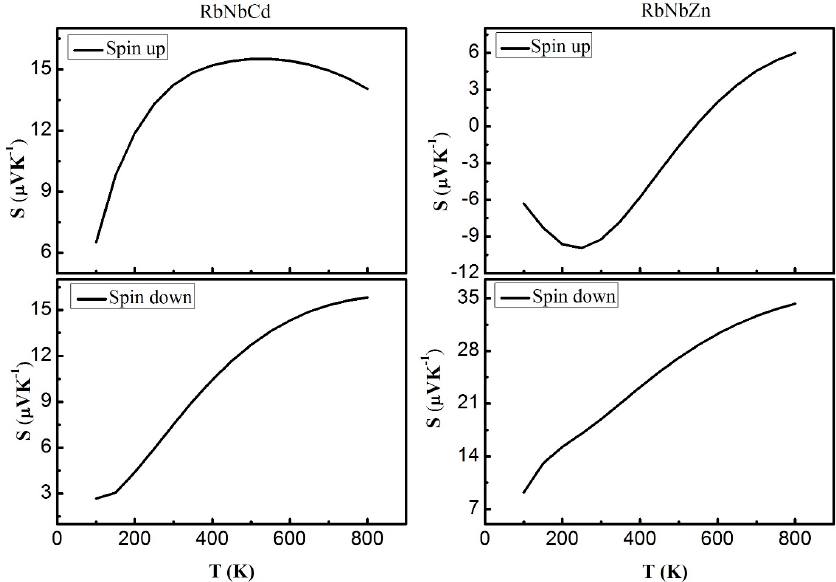
Figure 11. Temperature dependence of Seebeck coefficient ( S ) for RbNbCd and RbNbZn.